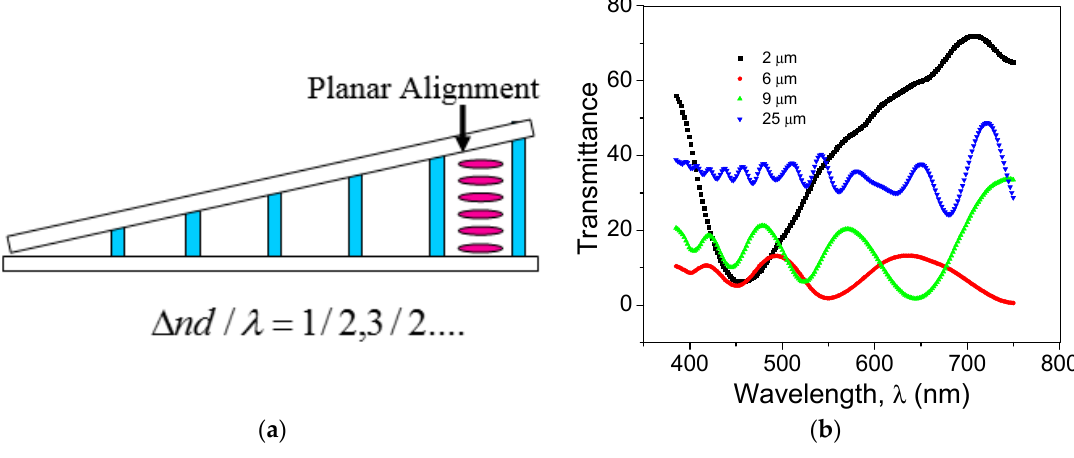
Figure 2. ( a ) Schematic of the wedge shaped cell and ( b ) graph showing the wavelength dependent transmittance of cells of different thicknesses.